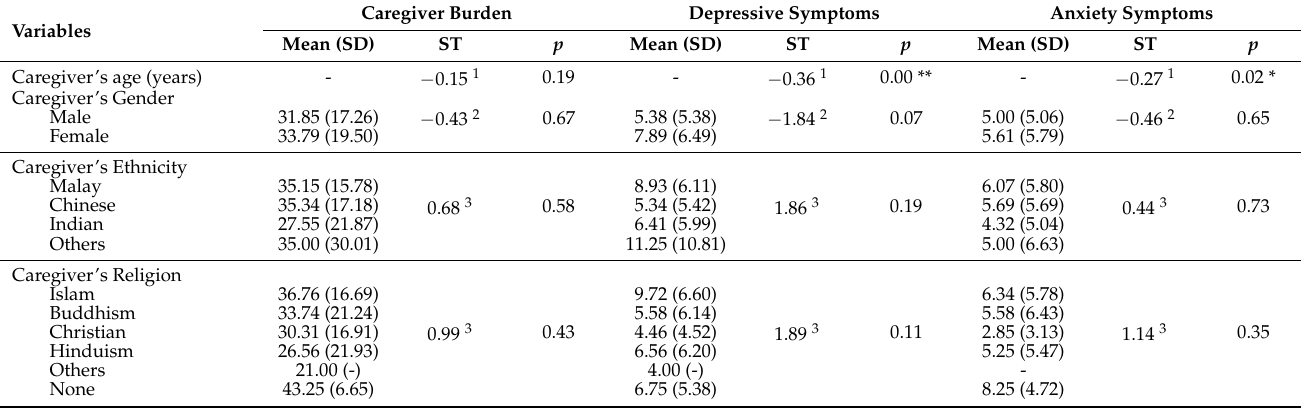
Table 7. Relationships between Caregiver Sociodemographics and Caregiver Burden, and Depressive and Anxiety Symptoms in Caregivers of